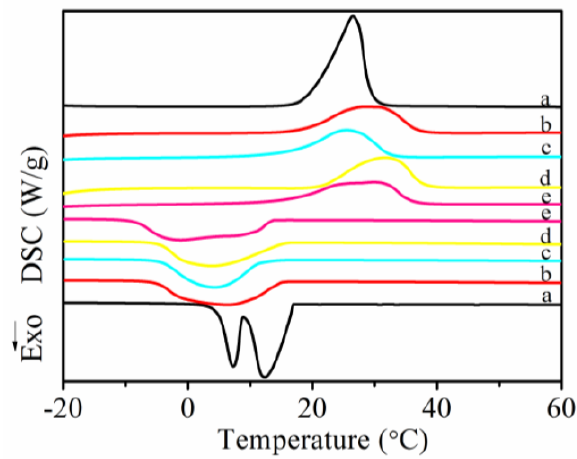
Figure 9. DSC thermograms comparison of various MicroPCMs and pure ethyl palmitate: ( a ) ethyl palmitate; ( b ) polyurea MicroPCMs; ( c ) polyurethane MicroPCMs; ( d ) polyurea–SiO 2 MicroPCMs ( e ) polyurethane–SiO 2 MicroPCMs. Table 1. Phase change performance comparison of various MicroPCMs and pure ethyl palmitate. T mo a Sample ( ◦